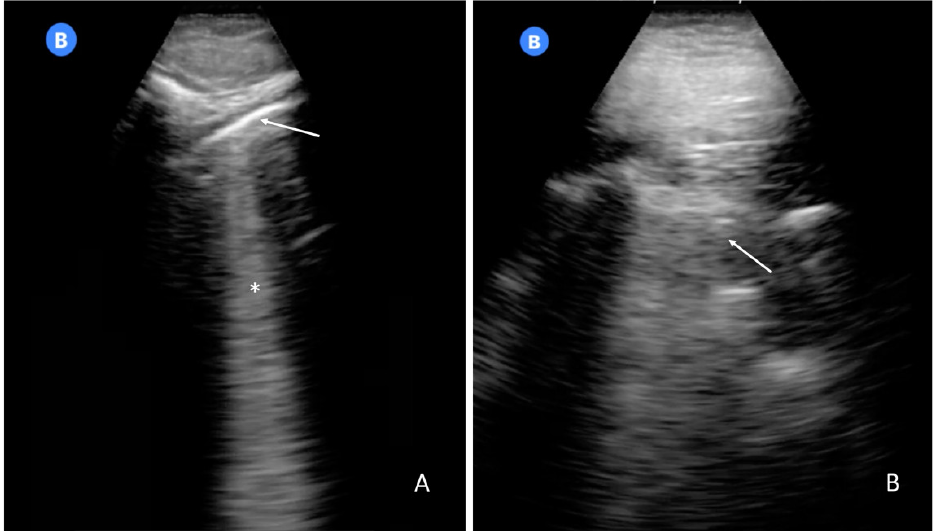
Figure 5. Most frequent findings in LUS self-performed by patients. Panel ( A ) shows a normal pleural line (arrow) and a B-line (asterisk—16). Panel ( B ) shows an irregular pleural line (see the arrow—16).